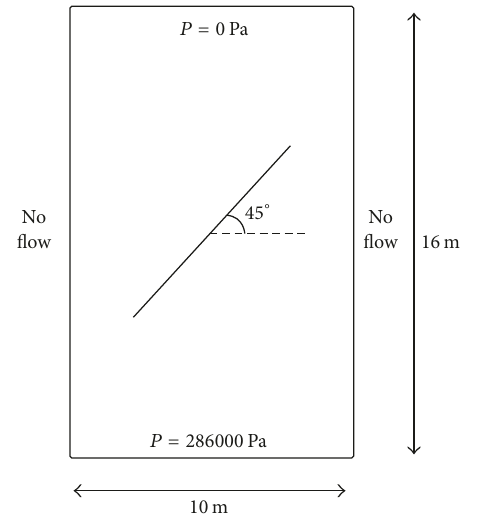
Figure 6: 2D Fractured media with applied pressure at top and bottom.